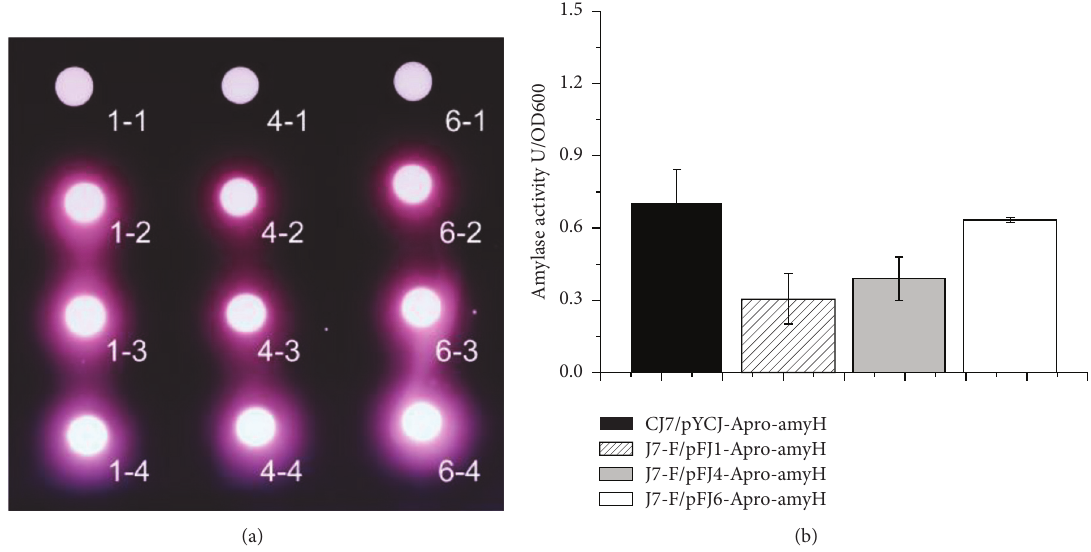
Figure 6: Amylase expression in J7-F cells using pFJ1, pFJ4, and pFJ6. (a) The pFJ1-A, pFJ4-A, and pFJ6-A plasmids were transformed into J7-F cells. Three random transformants were transferred to 5 mL of Halo-2 medium, grown to exponential phase, and 2 𝜇 L of each culture was spotted onto 18% MGM plates supplemented with 2% (w/v) soluble starch. After five days, iodine solution was added to the plates, and halos formed immediately around the selected transformants indicating that amylase was successfully expressed. 1-1: J7-F transformed with pFJ1 (negative control); 1-2, 1-3, and 1-4: J7-F transformants harboring pFJ1-A; 4-1: J7-F transformed with pFJ4 (negative control); 4-2, 4-3, and 4-4: J7-F transformants harboring pFJ4-A; 6-1: CJ7 cells transformed with pFJ6 (negative control); 6-2, 6-3, and 6-4: J7-F transformants harboring pFJ6-A (negative control). (b) Amylase-specific activities of supernatants collected from CJ7/pFJ1-Apro-amyH, CJ7/pFJ4-Apro- amyH, CJ7/pFJ6-Apro-amyH, and CJ7/pYCJ-Apro-amyH cultures. One unit of amylase activity was defined as the quantity of amylase required to hydrolyze 1mg of starch in